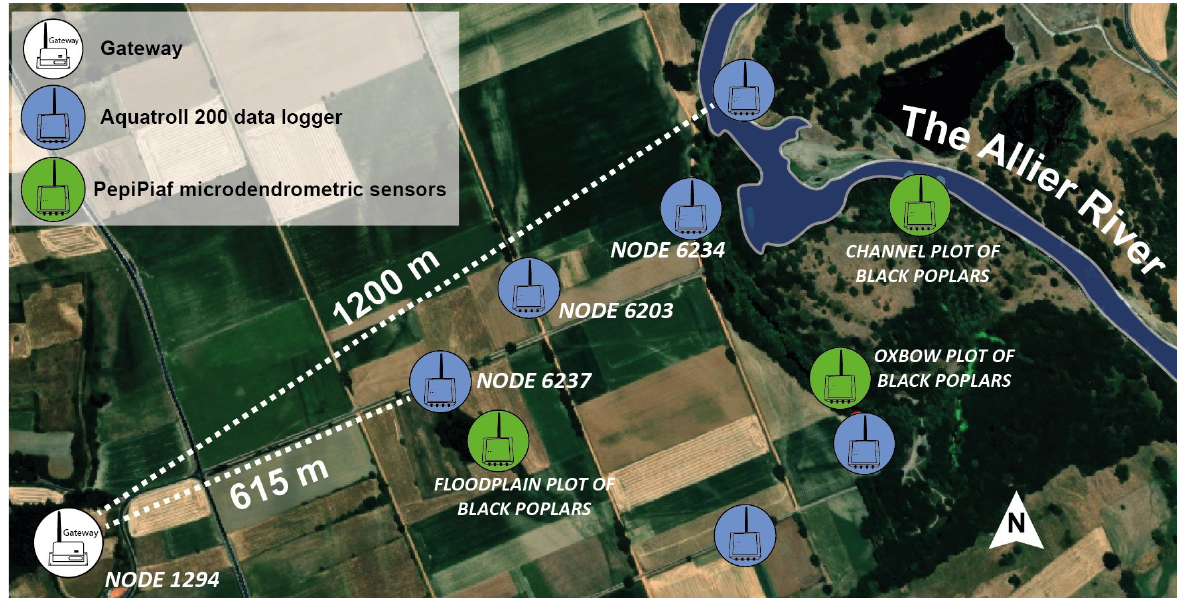
Figure 8. Location of sensors on the Auzon site (Image ©2023 Google, Images ©2023 CNES/Air-